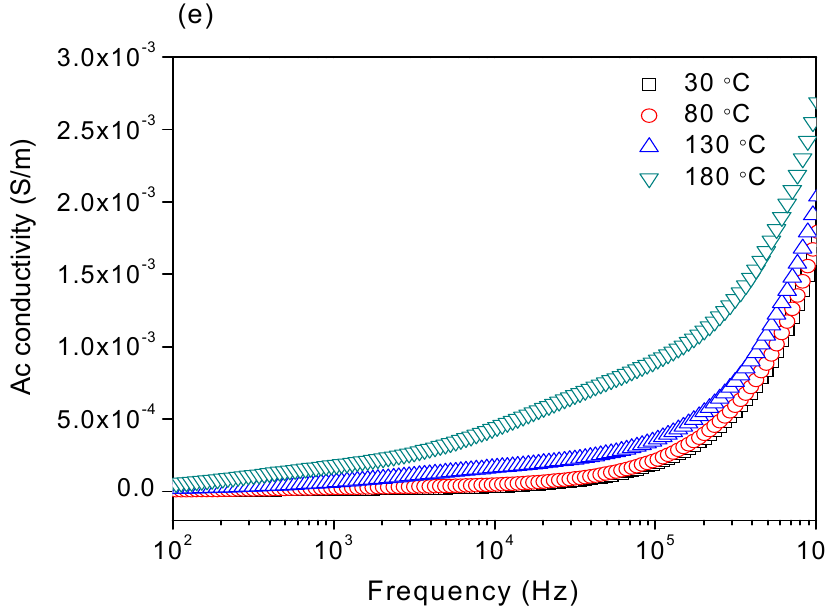
Figure 10. Variations of AC conductivity with respect to the frequency of BaFe 12 O 19 at different ratios ( a ) 1:3, ( b ) 1:4 ( c ) 1:5 ( d ) 1:6, and ( e ) 1:7.